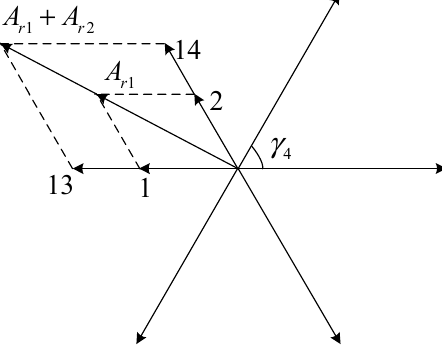
Figure 6. Slot electrical potential star Vectogram ( p = 4).